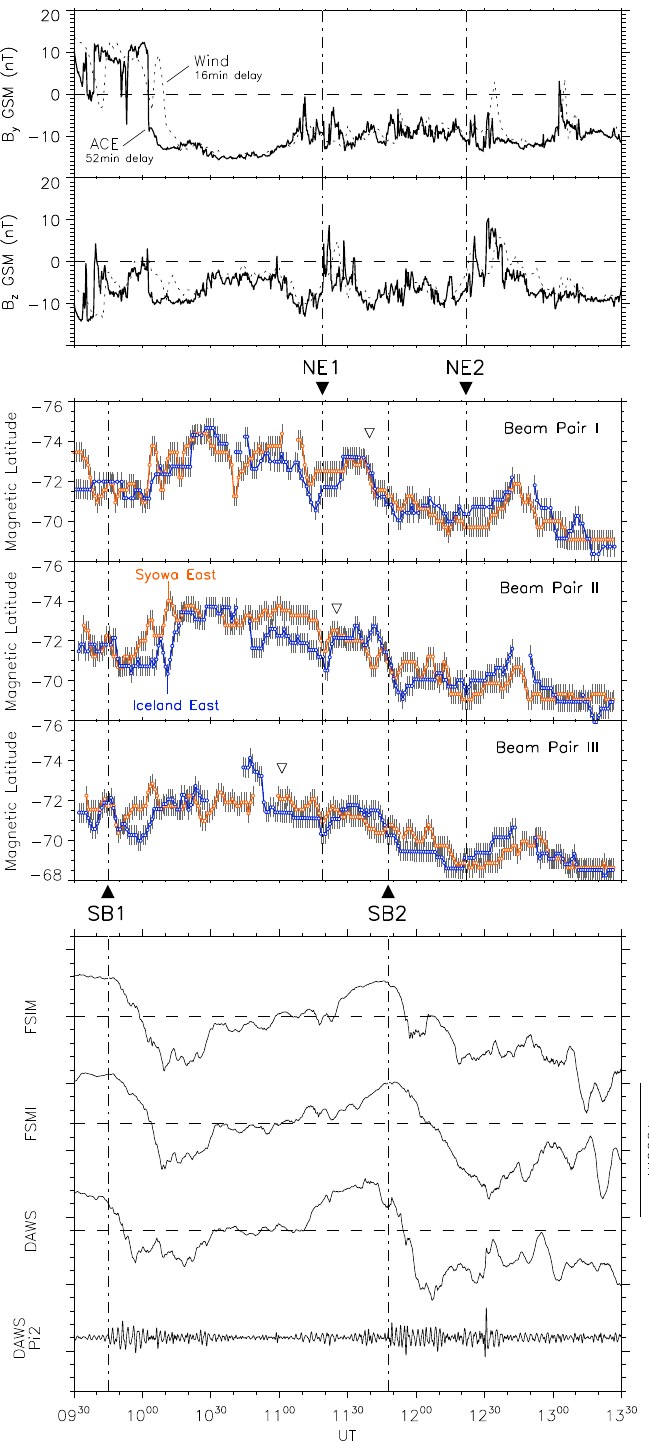
Fig. 4. (Top two panels) The B y and B z components of the IMF as measured by the ACE and Wind spacecraft (solid and dashed line, respectively), lagged to the magnetopause. Two vertical dashed lines indicate the time of the northward excursion of the IMF B z (“NE1” and “NE2”). (Middle three panels) The magnetic latitude of the spectral width boundaries identified for each conjugate beam pair, respectively. In each panel, the blue line indicates the boundary identified in Iceland East and the orange line indicates the boundary identified in Syowa East. Attached grey bars indicate uncertainties in the determination of the boundary latitude. (Bottom panel) H -component magnetograms from the CANOPUS networks, along with filtered data showing Pi2 activity (scaled by a factor of 5 for clarity). Vertical dashed lines indicate the onset of the two substorm breakup (“SB1” and